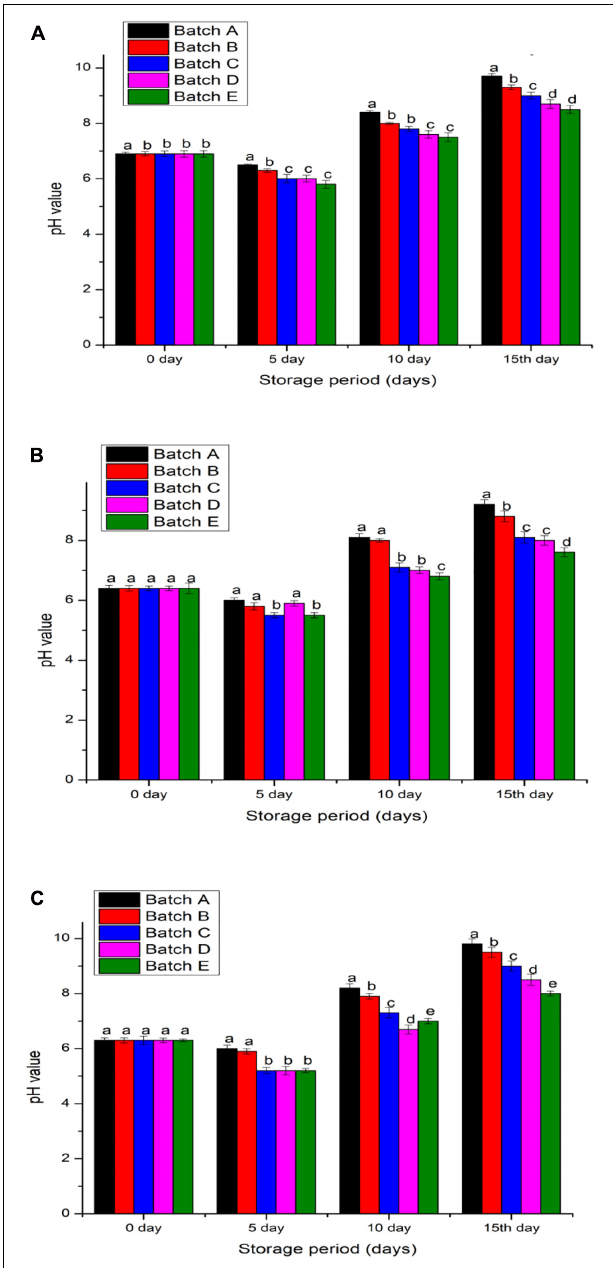
FIGURE 5 | pH value of samples (A) Penaeus merguiensis , (B) Pampus argenteus , and (C) Tenualosa ilisha. Batch A: normal untreated, Batch B: treated with 2% glacial acetic acid, Batches C, D, and E were treated with different types of 2% chitosan solutions (0, 10, and 20 kGy). Value is provided as mean ± SE ( n = 3). The same letters (a–e) over the bar plot stands for insignificant difference ( p > 0.05).